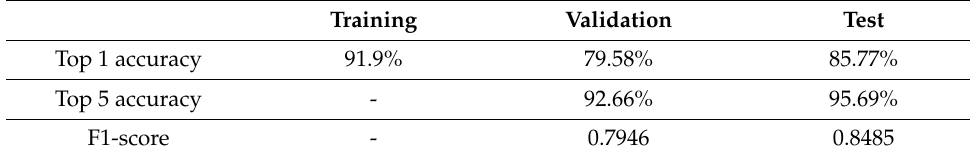
Table 5. Performance evaluation of the final